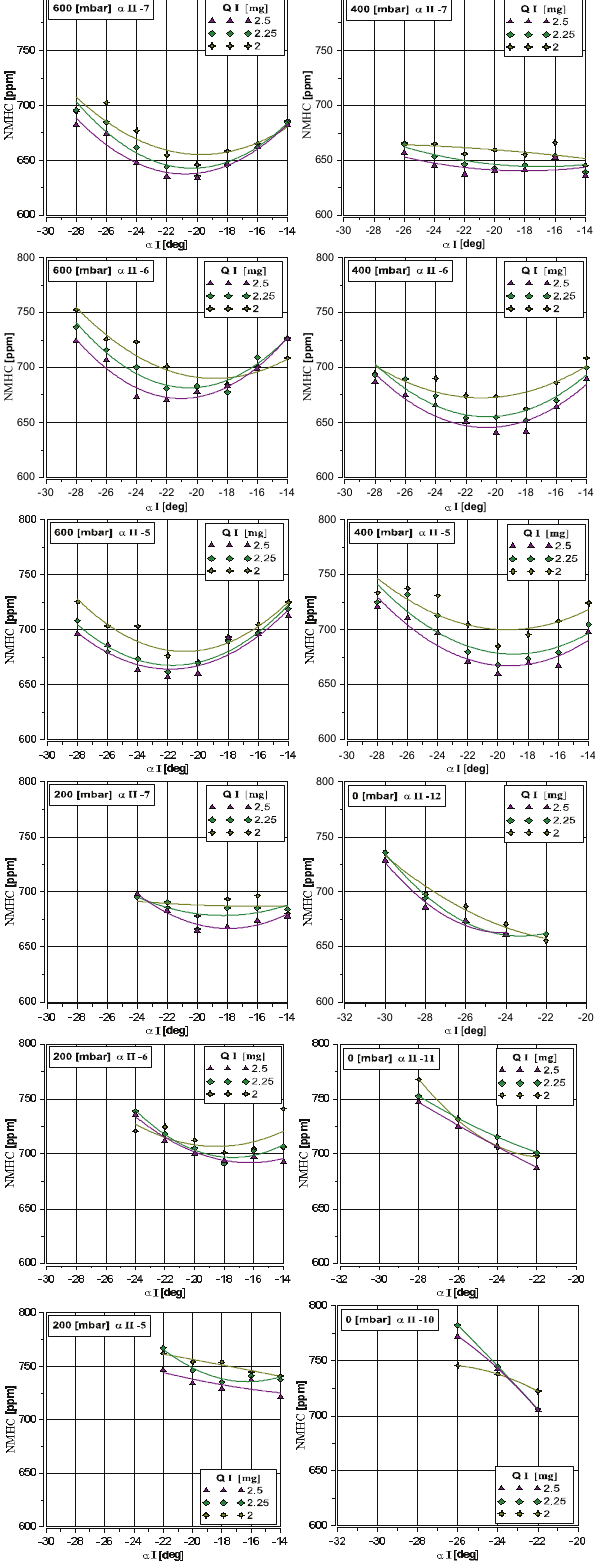
Fig. 5. Characteristics of variability of non-methane hydrocarbons (NMHC) content in the exhaust for different injection parameters of diesel fuel dose initiating